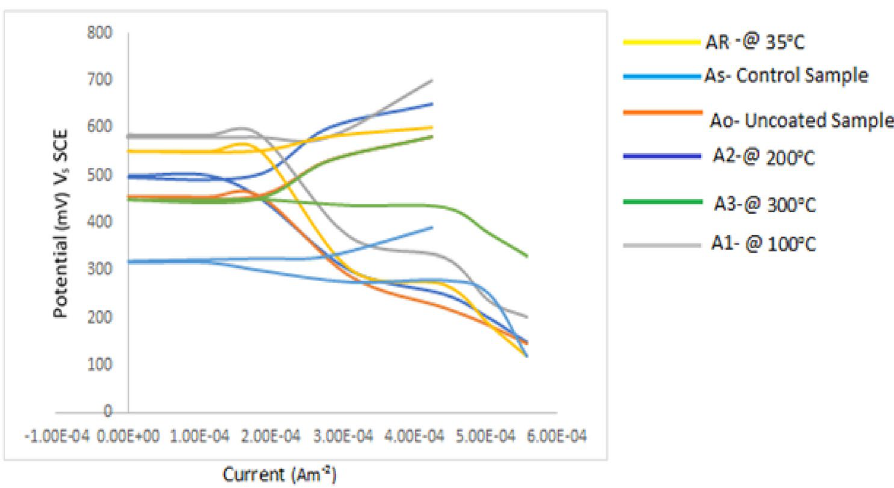
Figure 5. Potentiodynamic curves for Ag/Co 3 O 4 /TiO 2 nano composite coated AISI 1020 under various temperatures in seawater.